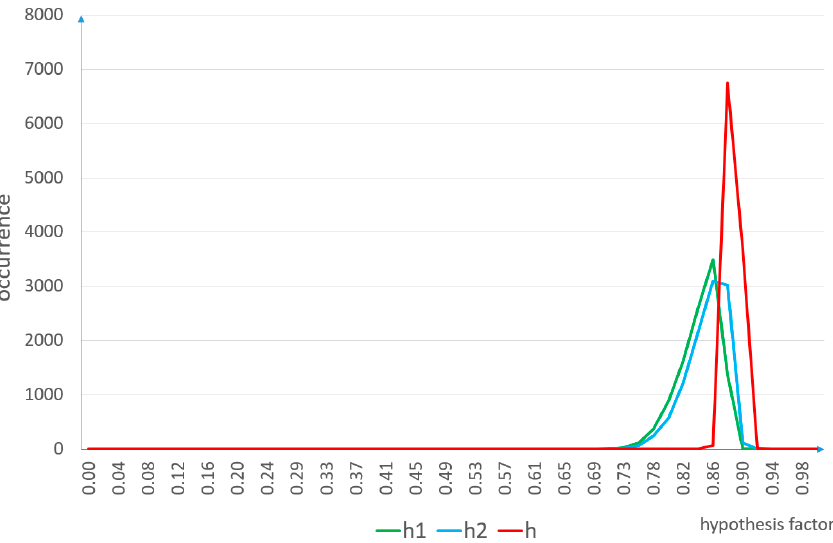
Figure 7. Simulation results of hypothesis h and intermediate hypotheses h1 and h2 (operation result of the software written by one of the authors of the article).